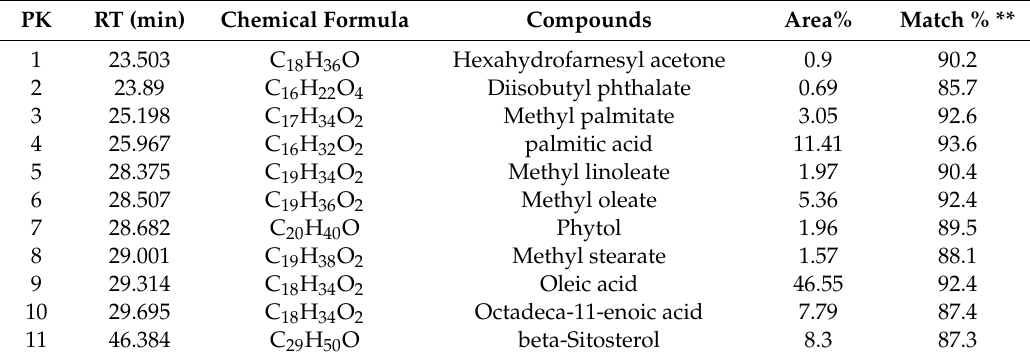
Figure 1. Gas chromatography–mass spectrometry (GC–MS) chromatogram of the P. huayllabambana n-hexane fraction. The peak numbers in this figure correspond to those used in Table 1. Table 1. Identified components from the n-hexane fraction of P. huayllabambana by gas chromatography– mass spectrometry (GC–MS)